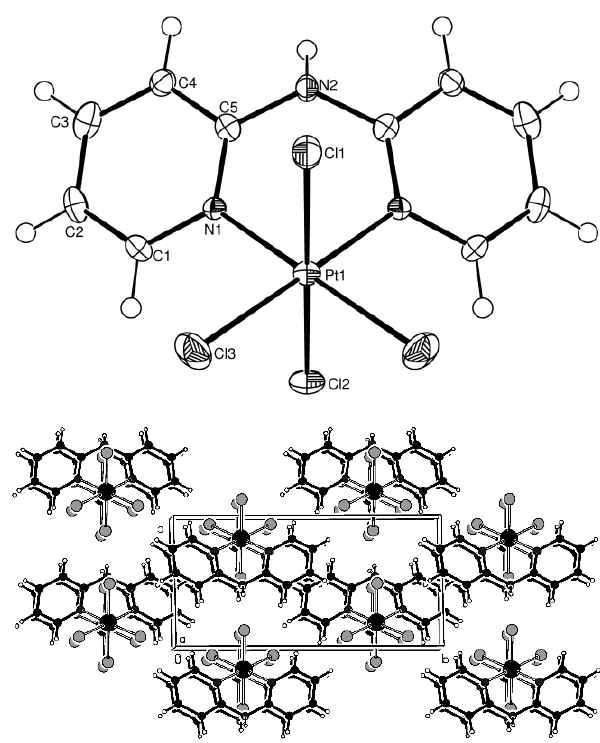
Table 1. Data collection and handling.